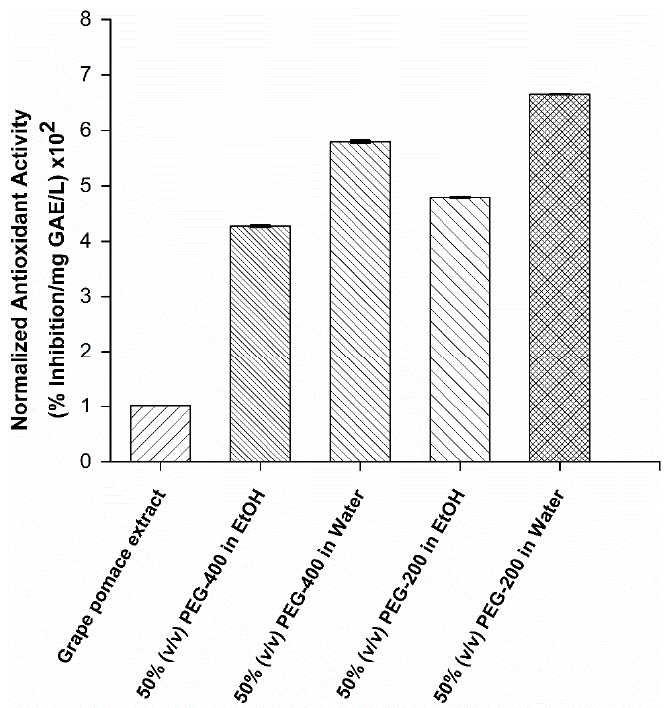
Figure 5. Normalized antioxidant activity of grape pomace extract and polyphenols recovered from mPEG-5000-grafted silica particles using various cosolvent systems. Ethanol is abbreviated as EtOH. A statistical difference was observed for all measurements ( p < 0.05) Error bars indicate a standard deviation observed for duplicates.